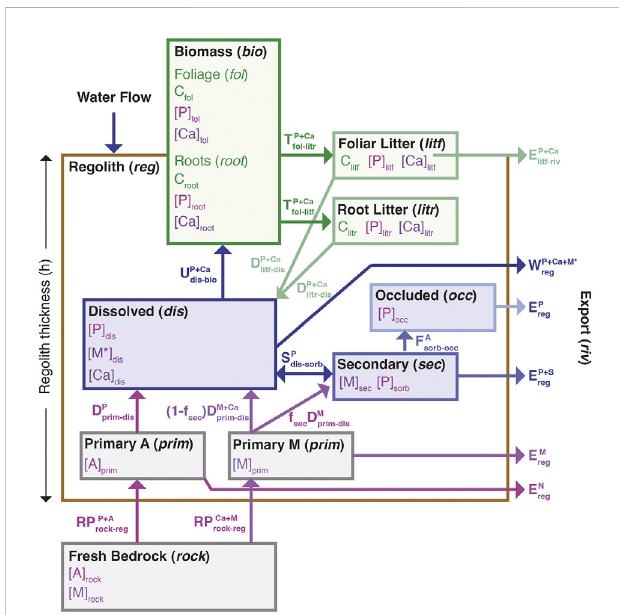
FIGURE 1 Conceptual model of plant nutrient uptake and exchange with regolith. The main reservoirs are shown as boxes with the relevant concentrations(squarebrackets)indicated.Thebrownboxdelineatesall sub-compartments of regolith. The fl uxes are shown by arrows. Phosphorous (P) is assumed to be the limiting nutrient supplied by an accessory mineral [A] prim , and calcium (Ca) is assumed to be a luxury nutrient supplied by a primary mineral [M] prim